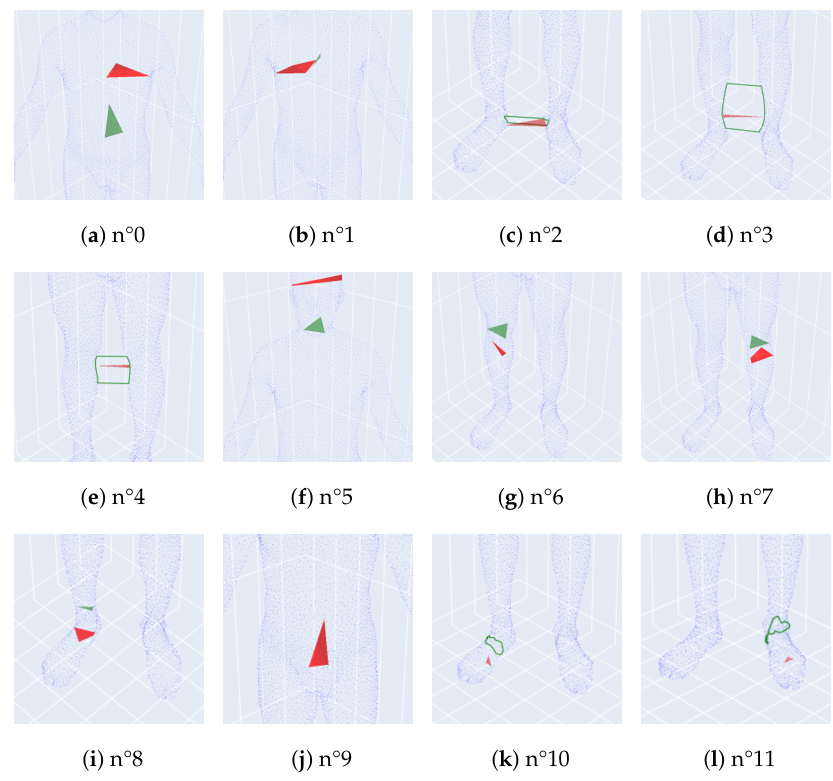
Figure 5. All non H 0 homologies of the persistence diagram of S0013